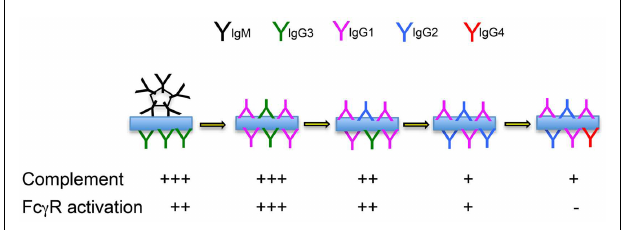
FIGURE 2 | Immune complex formation over the course of a prolonged immune response .The likely complement-fixing and Fc γ R-binding abilities of immune complexes formed by antibodies of mixed isotypes are